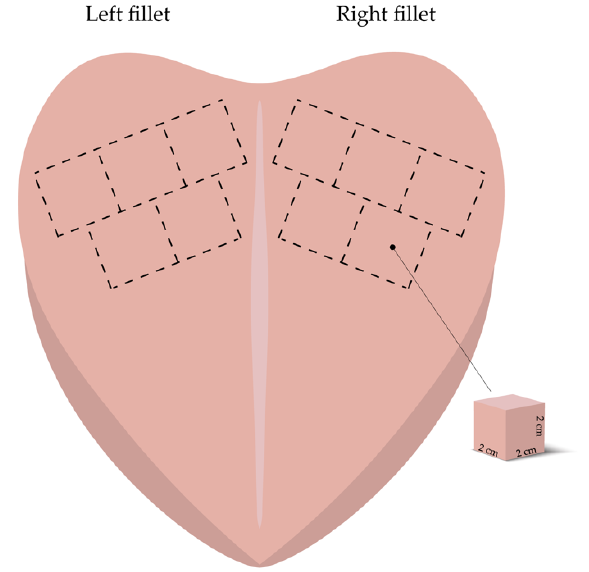
Figure 1. Sampling procedure adopted for the experiments. Meat samples were cut from the cranial position of each fillet following fibers direction ( n = 10 meat samples/breast muscle). Table 1. Pulsed electric field treatment parameters applied in experiment 1. Electric field strength and total specific energy input values are expressed as means ± standard deviation.